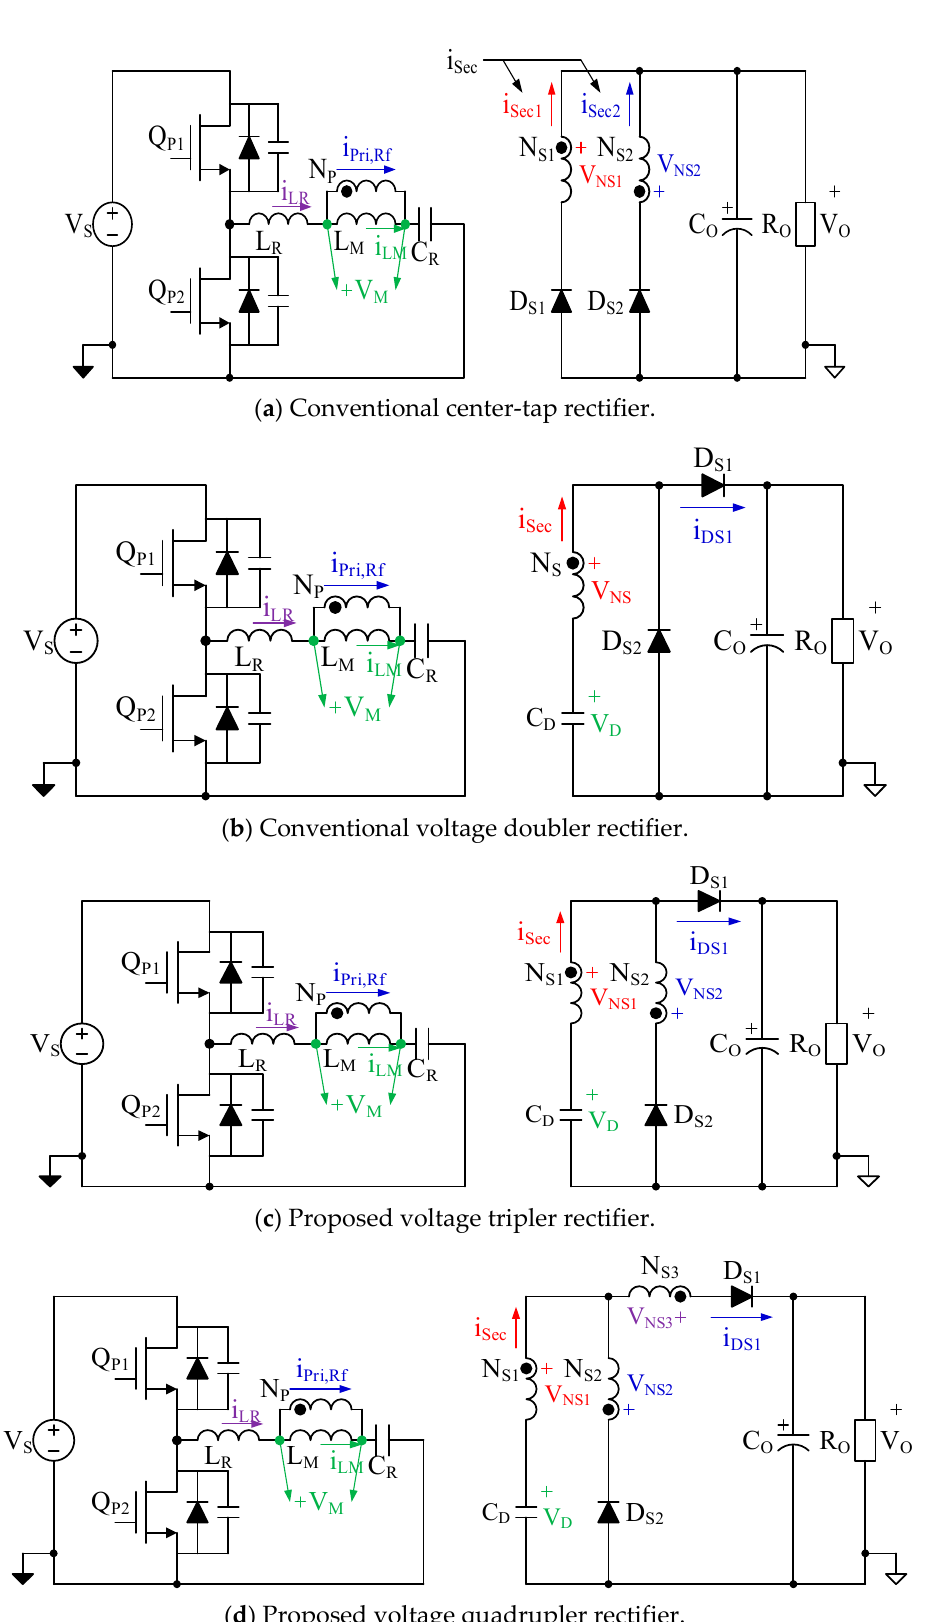
Figure 1. Circuit diagram of conventional and proposed rectifiers.